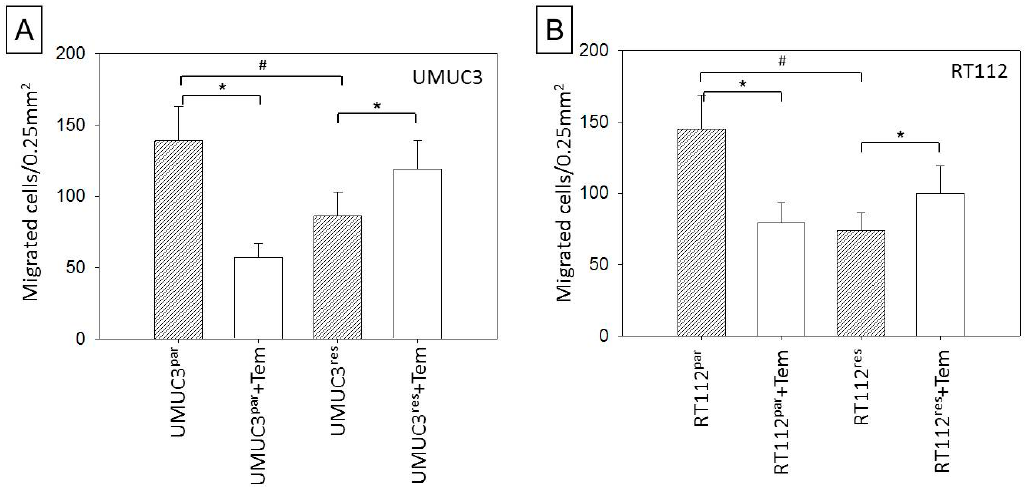
Figure 6. Effect of temsirolimus on chemotaxis in parental and temsirolimus-resistant ( A ) UMUC-3 and ( B ) RT112. Bladder cancer cells treated with 10 nmol/mL temsirolimus for 72 h. Chemotaxis through the membrane after 20 h was evaluated. Controls remained untreated. Bars indicate standard deviation (SD), * indicates significant difference to corresponding control, # indicates significant difference to parental control, p ≤ 0.05. n = 5.